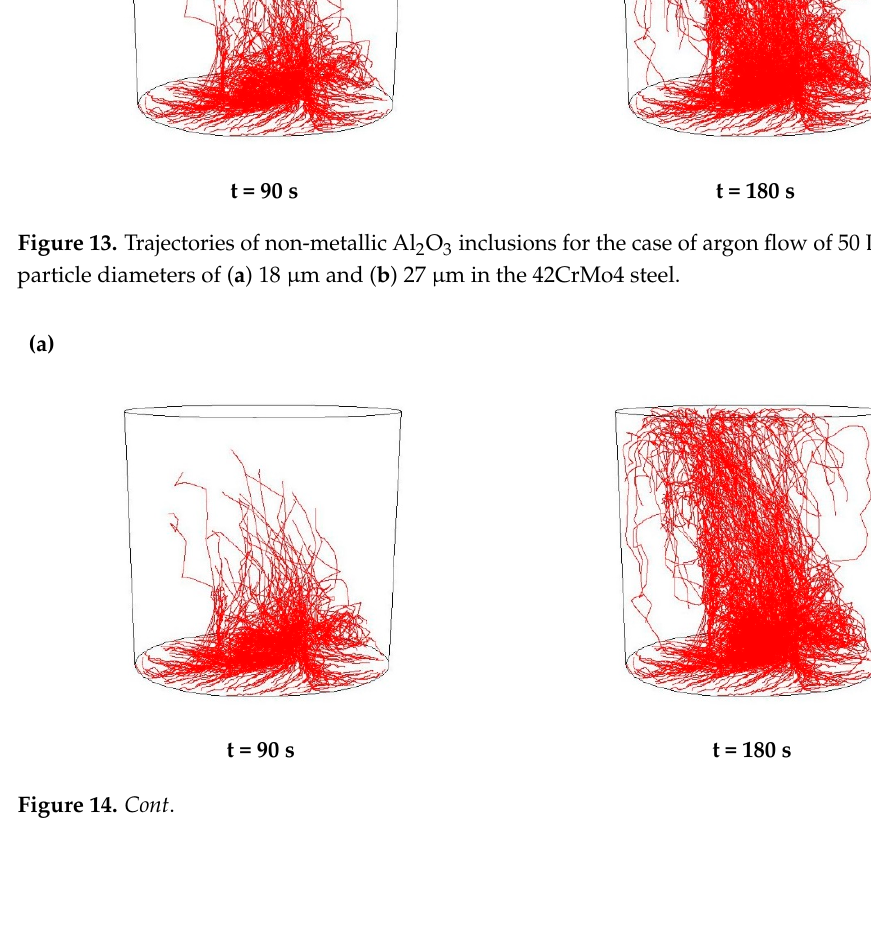
Figure 13. Trajectories of non-metallic Al 2 O 3 inclusions for the case of argon flow of 50 L/min for the particle diameters of ( a ) 18 µm and ( b ) 27 µm in the 42CrMo4 steel.